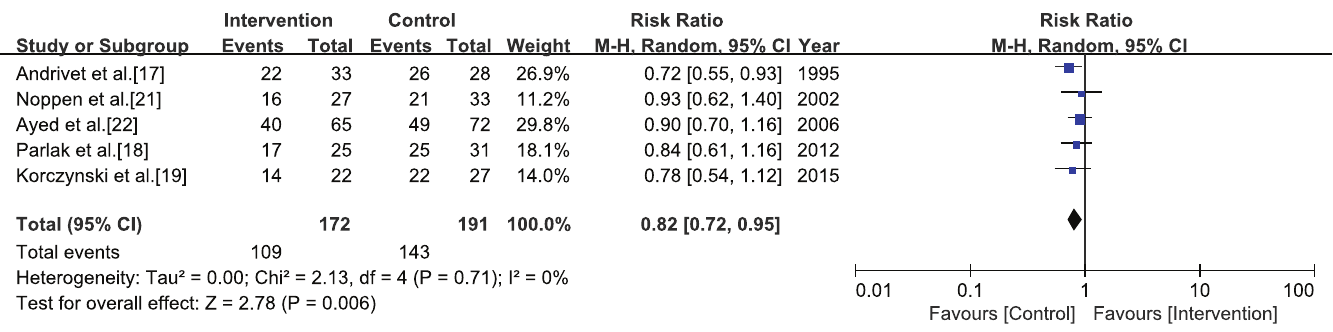
Fig 2. Meta-analysis of the early successrate associated with the aspiration versus intercostal tube drainage. The risk ratio for early success rate was used for effect size measure. The Mantel-Haenzel method and a random-effects model were used for calculatingthe pooledestimate.